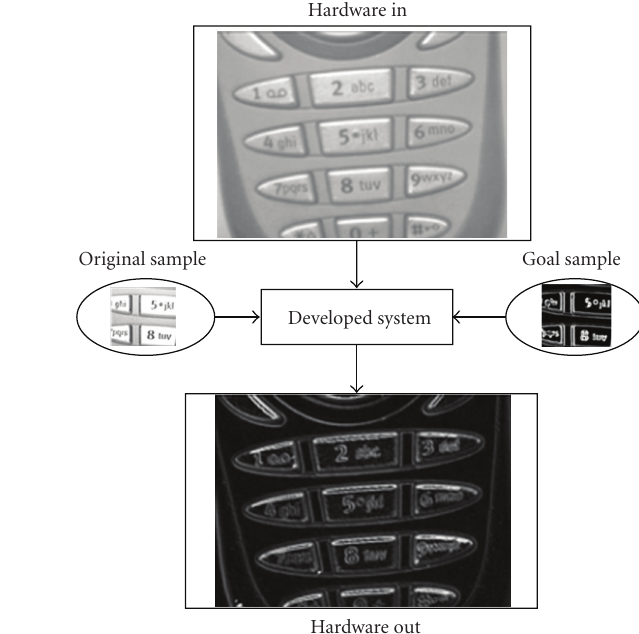
Figure 14: Emulation result of the Photoshop’s Glowing Edge filter implemented in hardware.